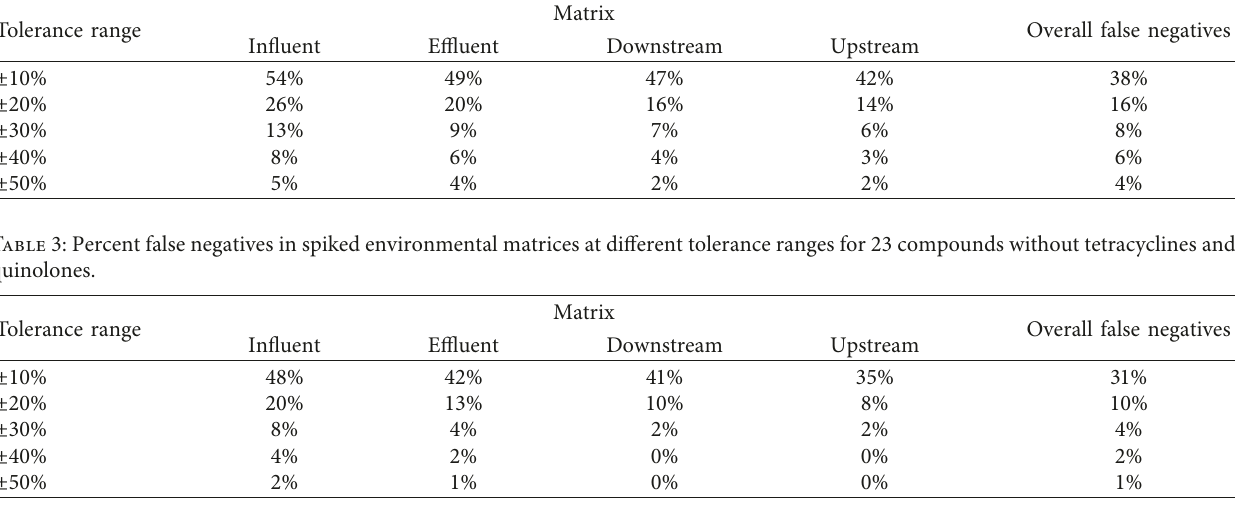
Overall false negatives